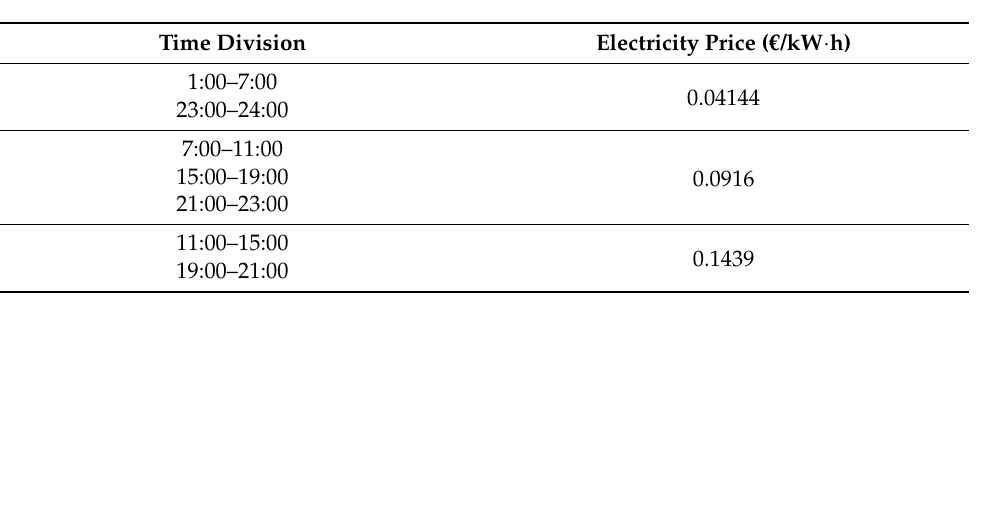
Table 5. TOU Power